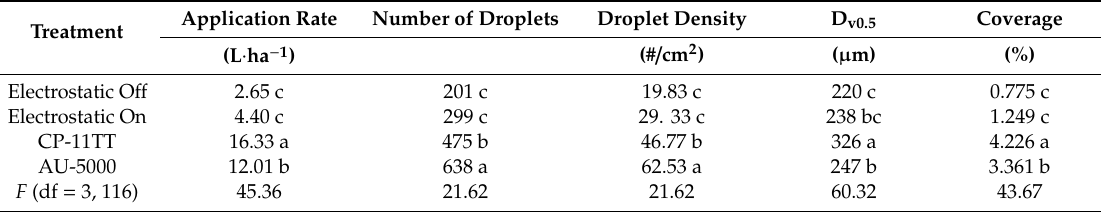
Table 5. Mean [a] spray droplet data collected on water sensitive paper samplers during year two.